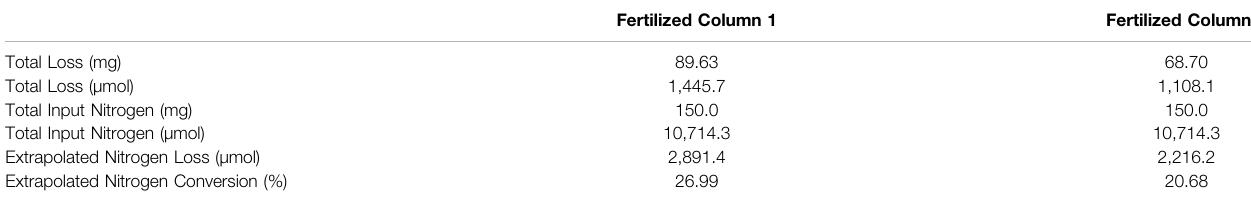
TABLE 3 | Mass balance of total nitrogen in two fertilized columns. Extrapolated nitrogen loss is estimated assuming experiment timeline only captured half of NO 3 −